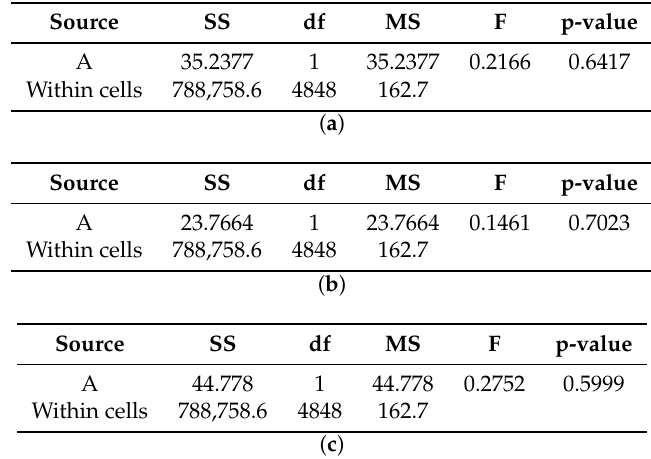
Figure A25. ANOVA tables for the analysis of the effect of factor A (initial position of the obstacle) on the convergence. ( a ) One-way ANOVA for factor A given B = 1 and C = 1. ( b ) One-way ANOVA for factor A given B = 1 and C = 2. ( c ) One-way ANOVA for factor A given B = 2.